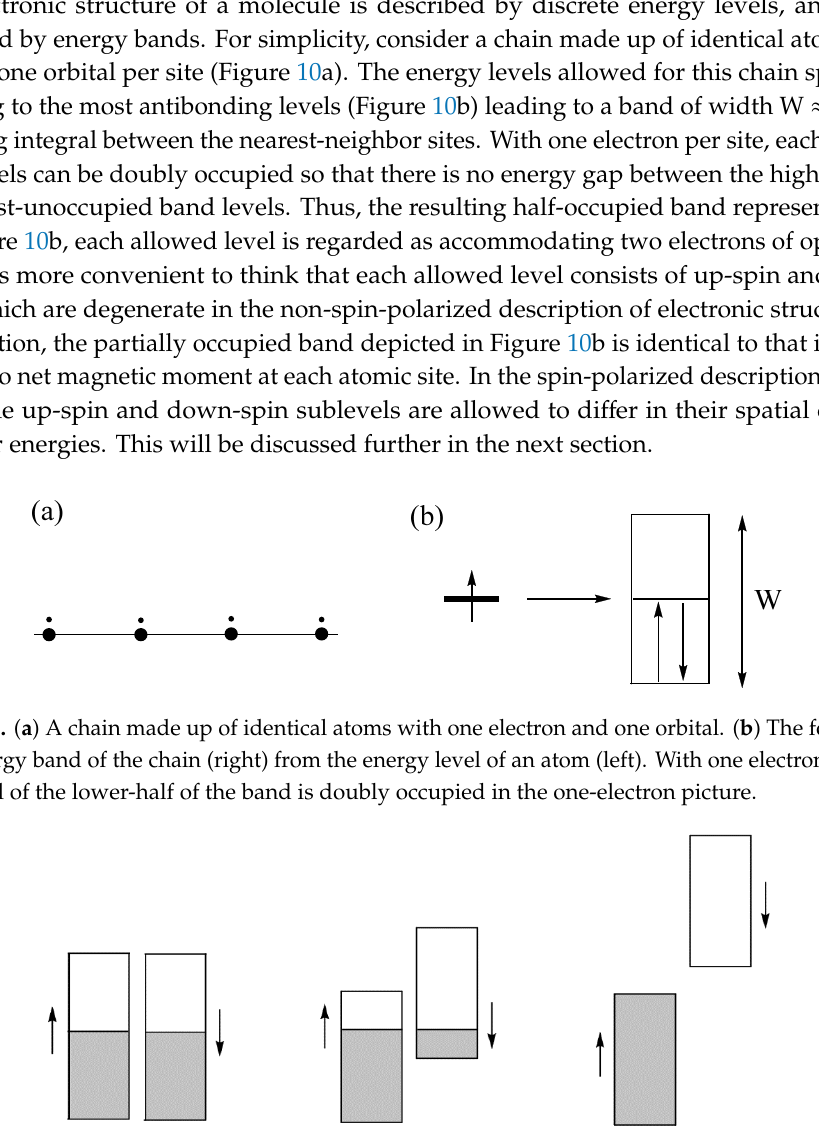
Figure 10. (a) A chain made up of identical atoms with one electron and one orbital. ( b ) The formation of an energy band of the chain (right) from the energy level of an atom (left). With one electron per site, each level of the lower-half of the band is doubly occupied in the one-electron picture.